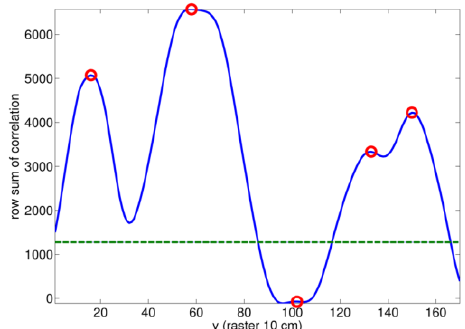
Figure 6. Example for a function of the sum over the values of all columns in the correlation image for each row (= height profile). The peaks in the function, indicating window positions, are marked with circles. The dashed line shows the threshold for accepting peaks as window